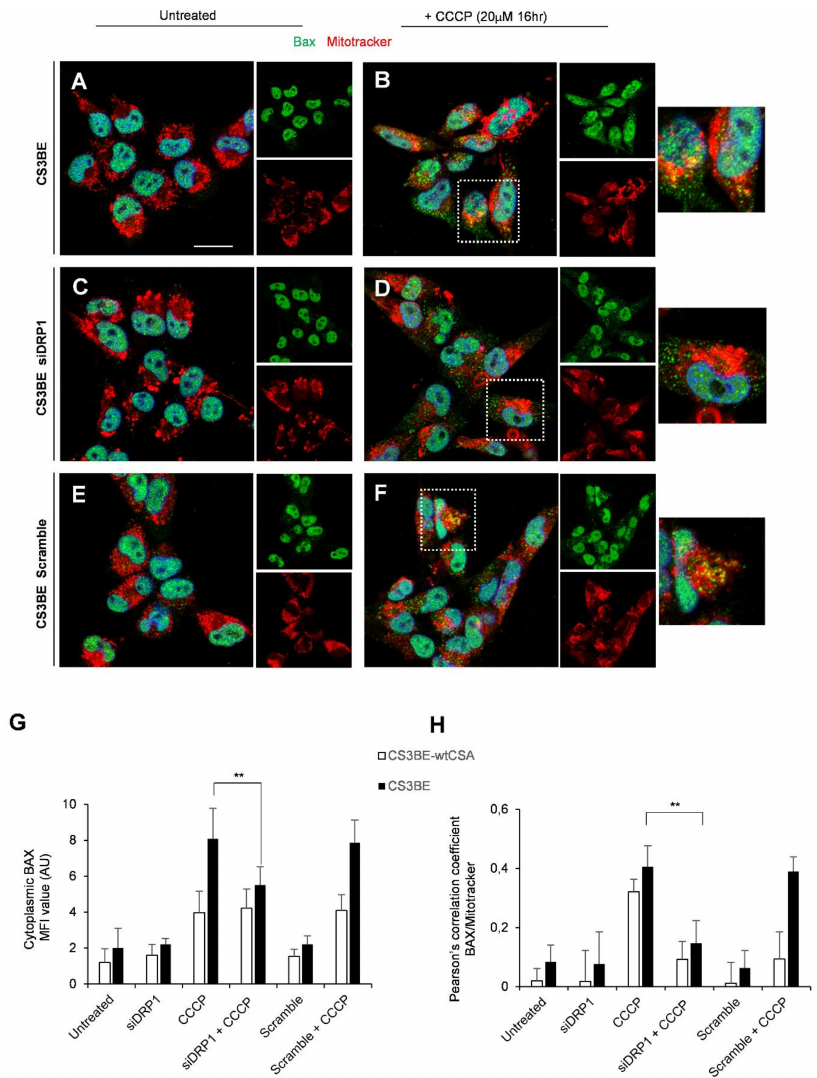
Figure 6. DRP1 silencing decreases the level of apoptotic Bax at mitochondria. ( A – F ) Detection of Bax and mitochondria by CLSM examinations in CS3BE cells. ( A , C , E ) untreated; ( B , D , F ) CCCP (20 µ M for 16 h) treated ; (C , D ) after DRP1 silencing; ( E , F ) in the presence of Scramble. Living cells were stained with Mitotracker ® Deep Red FM (detected in red), fixed, permeabilized and labelled with polyclonal anti-Bax Ab (green). Nuclei are stained in blue (DAPI). Colocalization areas (detected in yellow) are shown in merged images. Insets represent separate channel images. For CCCP treatment a higher-power magnification image of a selected cell for each experimental condition is shown on the right. Scale bars, 20 µ m. Panels are representative of two independent experiments. ( G ) Mean fluorescence value of cytoplasmic Bax in each experimental condition. ( H ) Quantification of colocalization of Bax with mitochondria after DRP1 silencing and/or CCCP treatment, as determined by Pearson’s correlation coefficient measured in all microscopy images (mean ± SD). ** p < 0.01 by Mann–Whitney